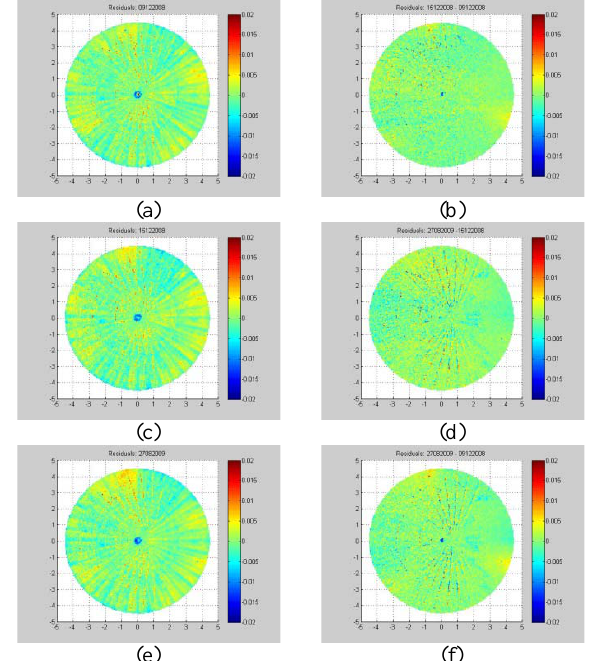
Figure 9: Residual plot of the dish on (a) 9 Dec 2008, (c) 15 Dec 2008 and (e) 27 August 2009. (b) is the difference between the 9 Dec 2008 and the 15 Dec 2008. (d) is the difference between the 15 Dec 2008 and the 27 Aug 2009. (f) is the difference between the 9 Dec 2008 and the 27 Aug 2009.